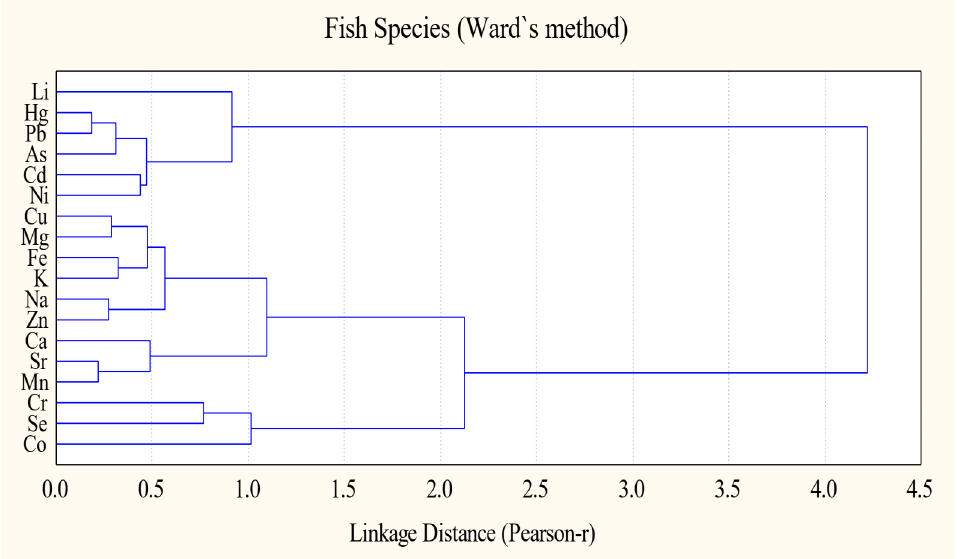
Figure 3. Cluster analysis of selected metals in Catla catla